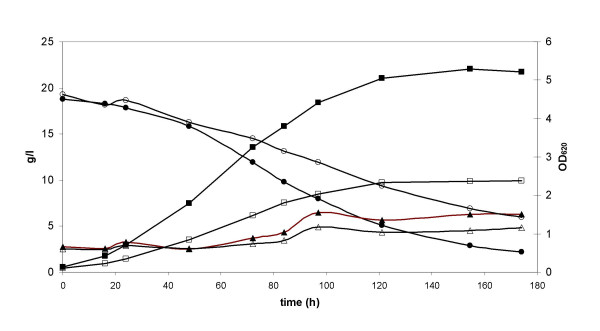
Xylose utilisation and product formation during oxygen-limited cultivation of TMB 3400 [29] in YP and YNB media. Xylose YP-●-, Xylose YNB -○-, Ethanol YP -▴-, Ethanol YNB -△-, OD620 YP -■-, OD620 YNB -□- Sugars and products were analyzed with HPLC (Bio-Rad, Aminex 87-H column).